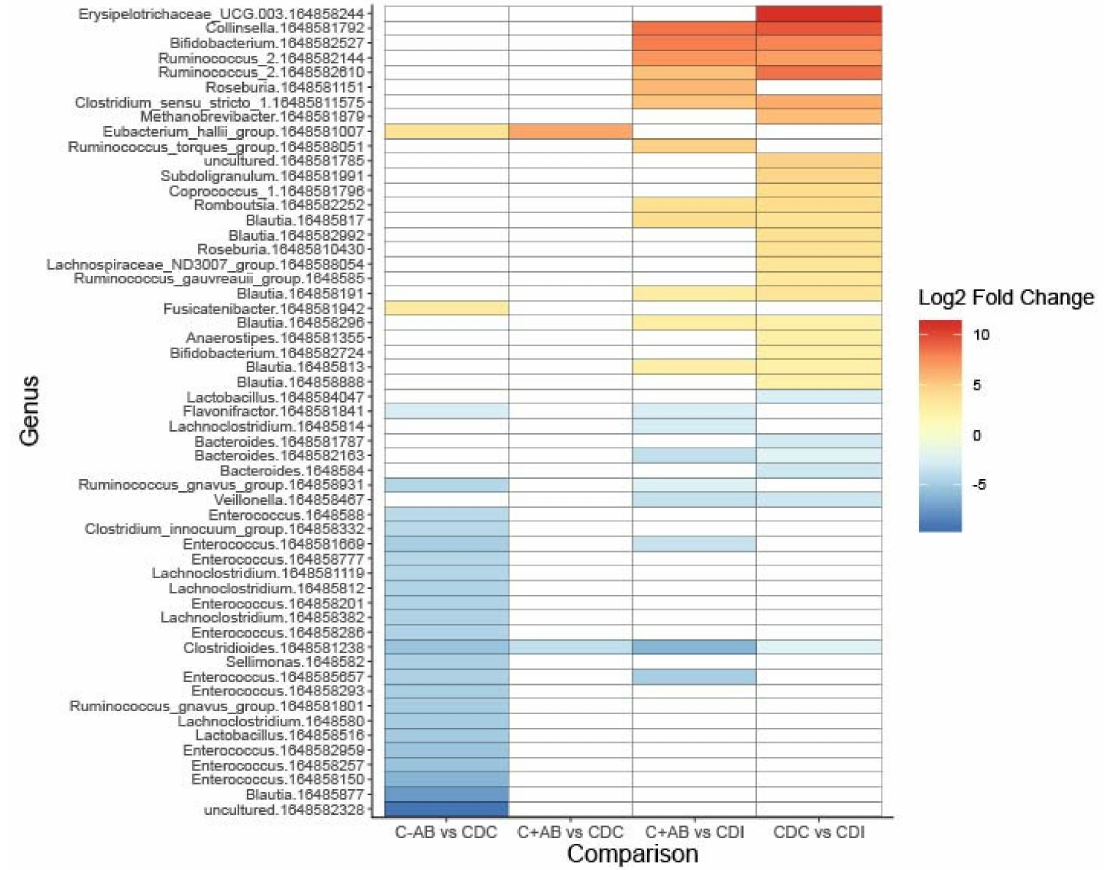
Figure 3. Heatmap showing di ff erentially abundant bacterial taxa between without previous antibiotic use (C-AB), with previous antibiotic use (C + AB), CDC and CDI patients. Bacterial taxa with a Log2 fold change of at least (-)2.25 and a Benjamini–Hochberg corrected p -value ≤ 0.05 are shown on operational taxonomic unit (OTU)-level. OTU numbers are indicated as 164858xxxxxx. A full overview can be found in Table